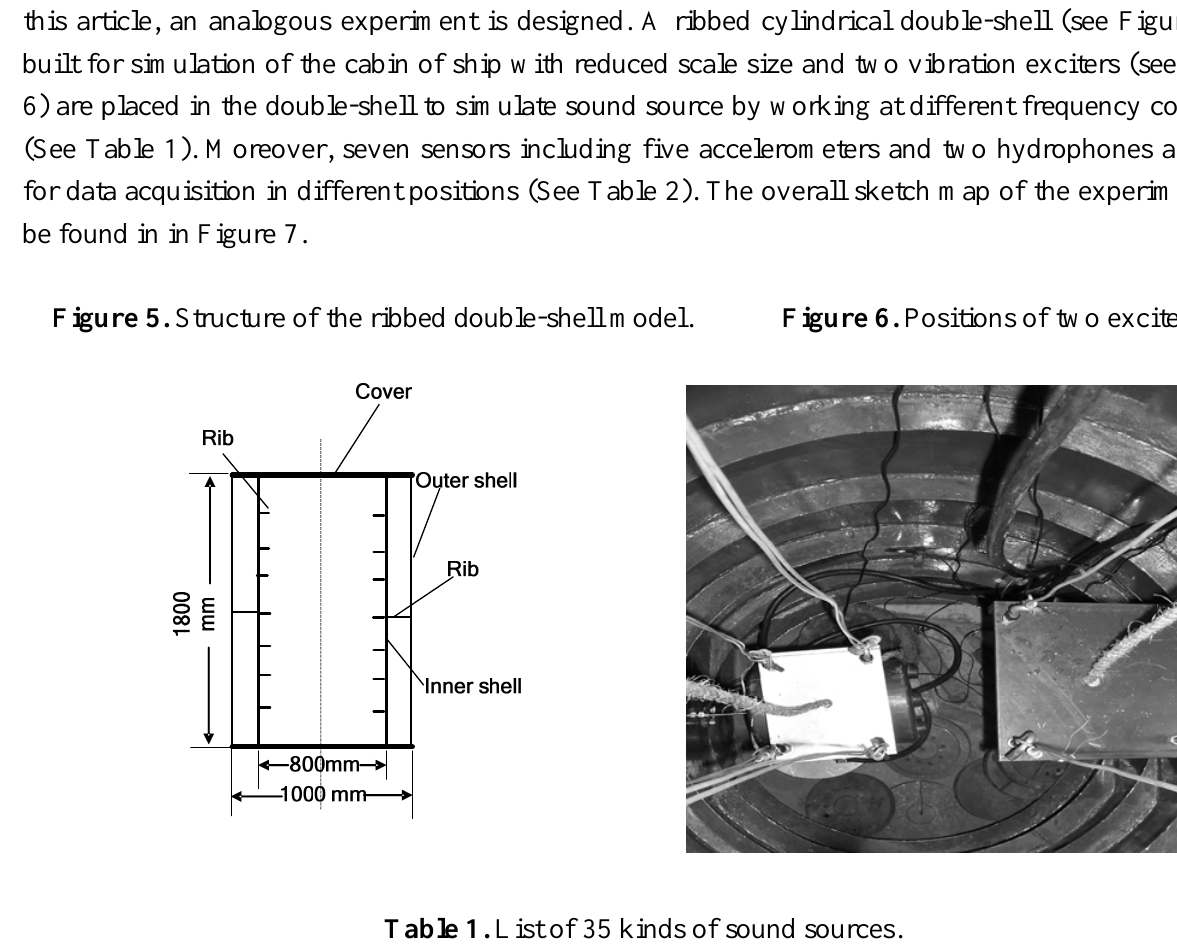
Table 1. List of 35 kinds of sound